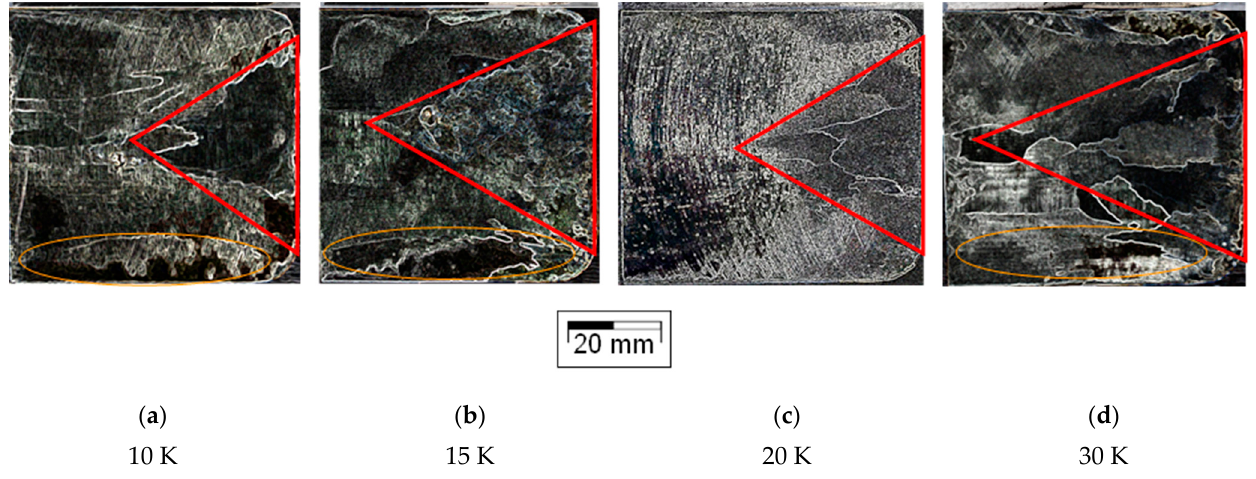
Figure 6. Grain structure of samples 4.1.A ( a ), 5.1.A ( b ), 1.1.A ( c ), and 6.1.A ( d ) at a cooling rate of 10 K/h and temperature gradient of 10, 15, 20, and 30 K. 10 K/h and temperature gradient of 10, 15, 20, and 30